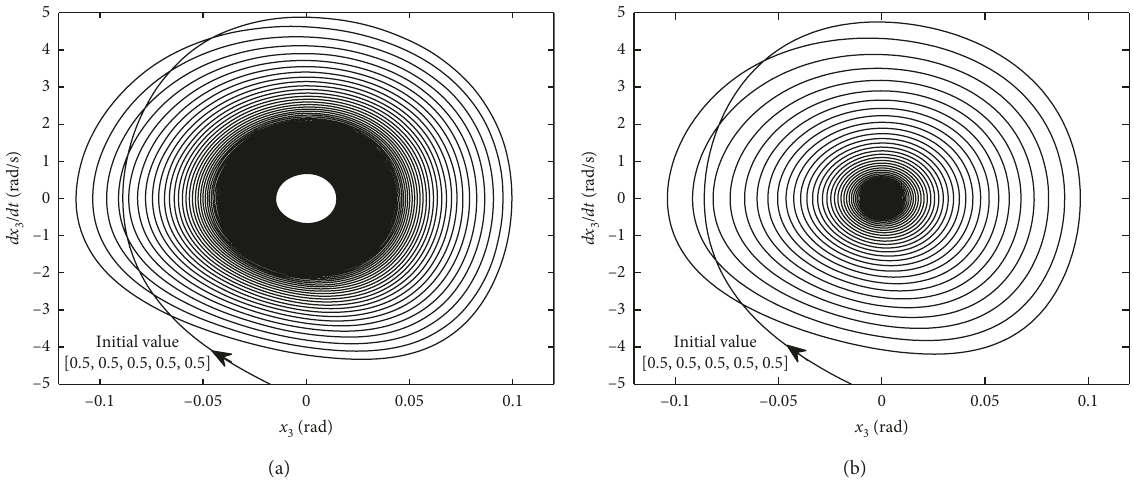
Figure 7: Comparison of phase trajectory between original system and controlled system at the critical damping point: (a) original system; (b) controlled